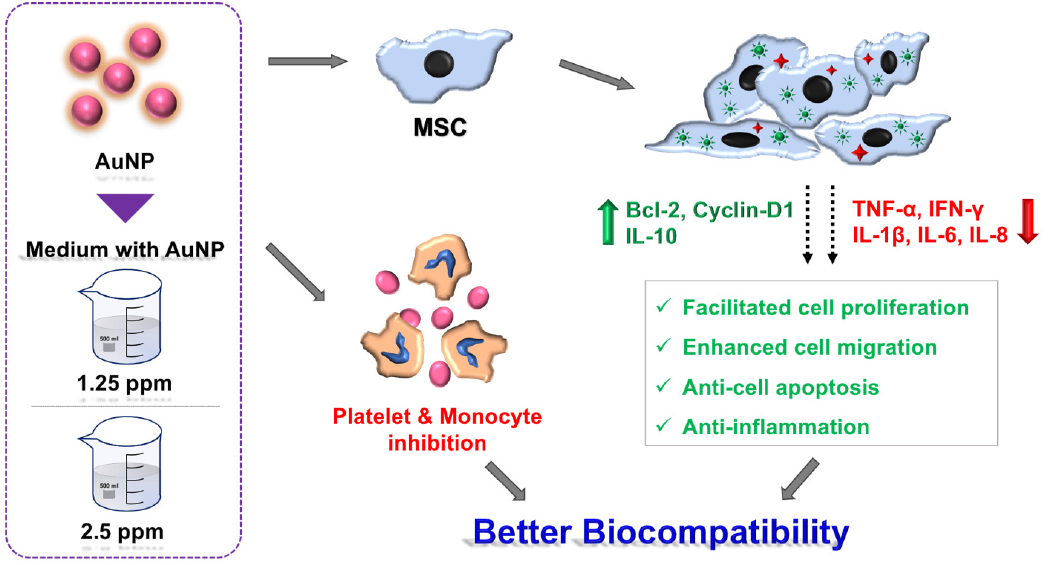
Figure 12. Schematic illustration. In line with our investigations, AuNP at the concentrations of 1.25 and 2.5 ppm facilitated better biocompatibility and biological performance, with the enhancement of cell proliferation, migration and anti-immune response capacities. Additionally, the 1.25 and 2.5 ppm AuNP treatments also prevented MSCs from apoptosis. In conclusion, 1.25 and 2.5 ppm AuNPs are suggested to be better concentrations for the biomedical approach in drug delivery or nanomaterial modification.